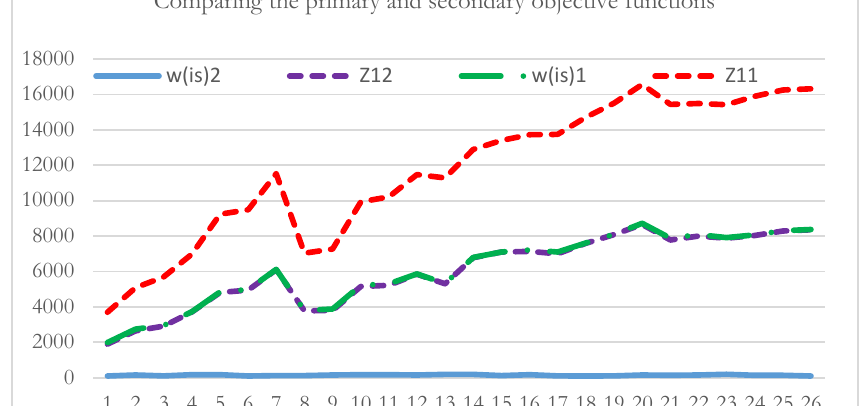
Fig. 3. Comparing the primary and secondary objective functions in terms of changes in the demand.